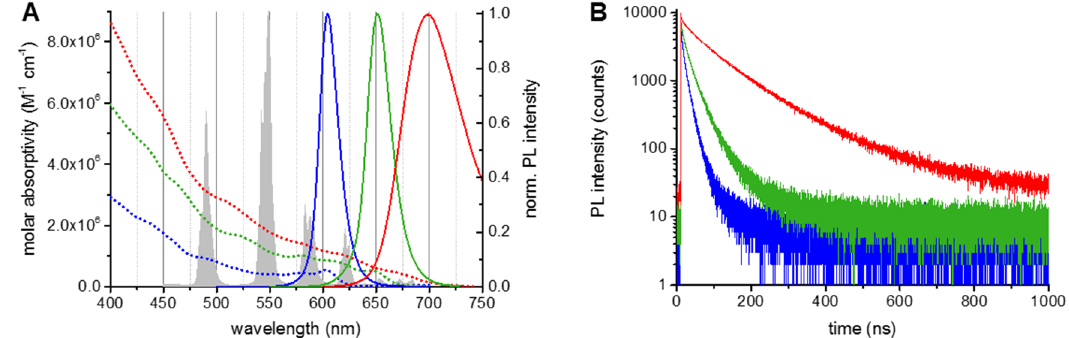
Figure 2. Optical characterizations of QD-AB conjugates. ( A ) Absorption (dotted lines) and PL (solid lines) of QD605 ( blue ), QD655 ( green ) and QD705 ( red ). To show the spectral overlap between Tb emission and QD absorption and the differences in PL wavelengths also the Tb PL spectrum is shown (gray spectrum in the background). Förster distances were calculated as R 0 (QD605) = 8.8 ± 0.4 nm, R 0 (QD655) = 10.5 ± 0.5 nm, and R 0 (QD705) = 11.2 ± 0.6 nm; ( B ) Pulsed (405 nm diode laser at 1 MHz) excitation was used to measure the PL decay curves at the respective PL peaks of the QDs. The multi-exponential decay curves (same colors as in A ) gave amplitude-averaged decay times of τ (QD605) = 6.3 ± 1.2 ns, τ (QD655) = 14.0 ± 0.9 ns, and τ (QD705) = 80.0 ± 3.0 ns.